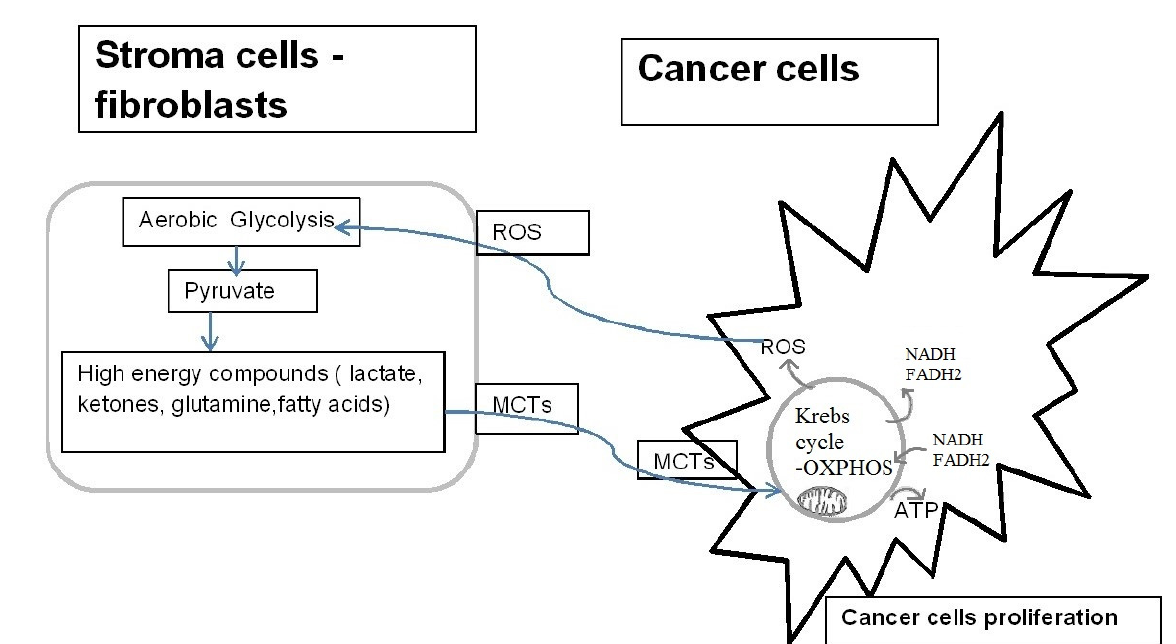
Figure 3. Reverse Warburg effect. Reactive Oxygen Species (ROS) secreted by cancer cells induce aerobic glycolysis in neighboring stromal fibroblasts. The high-energy compounds produced as a result of aerobic glycolysis are transported back to the cancer cells. These compounds are to be used for anabolic processes and the formation of ATP in the process of aerobic respiration by cancer cells, which is assumed to contribute to the progression of cancer. MCTs-monocarboxylate transporters,-plasma membrane transporters that carry molecules having one carboxylate group.